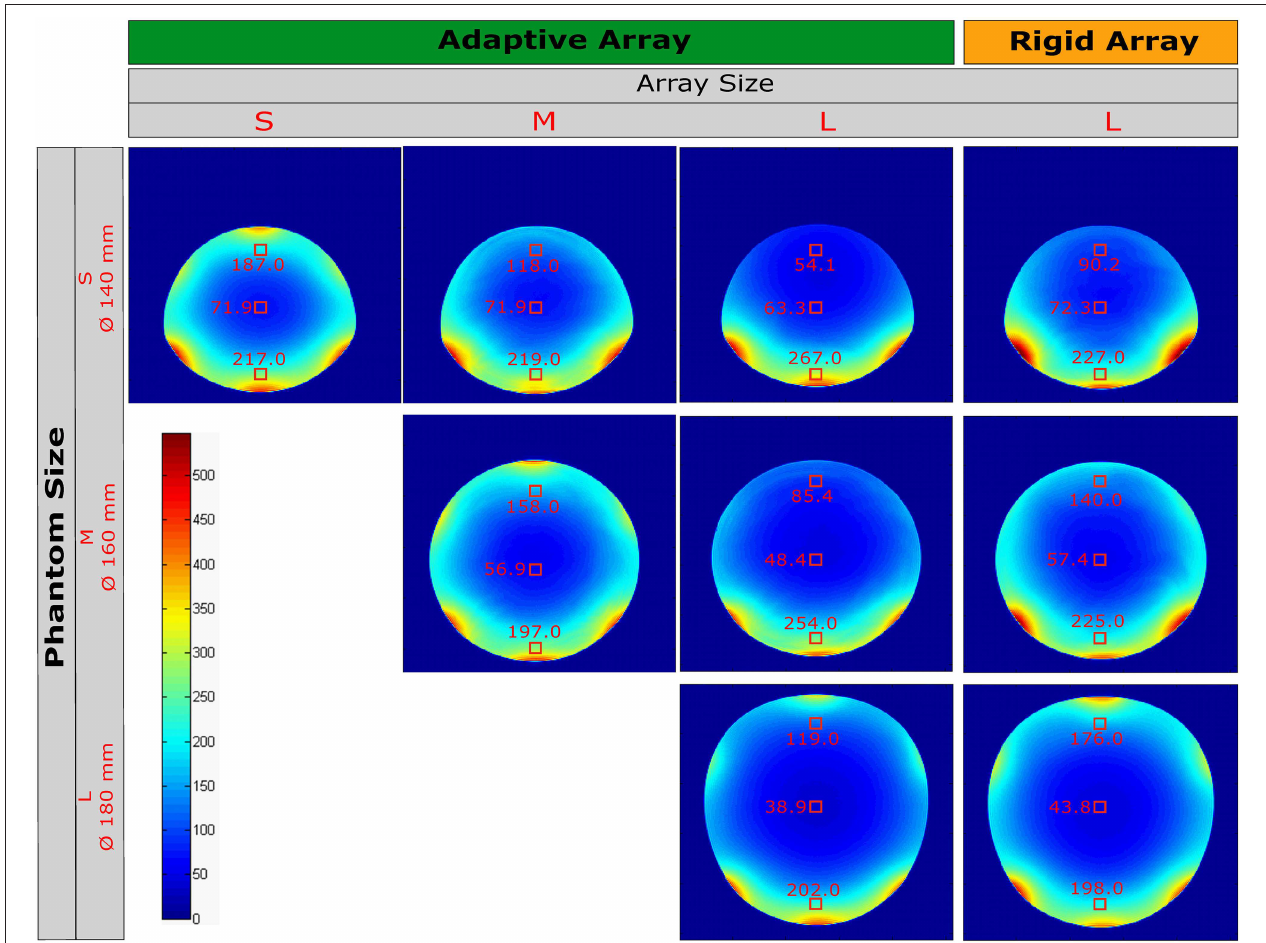
FIGURE 7 | SNR comparison for the adaptive and rigid knee arrays for different phantom sizes. The SNR was measured at three representative points: at the center of each phantom, 25mm away from the lower shell and 25mm away from the top of each phantom. The experimental setup is illustrated in Figure 4B